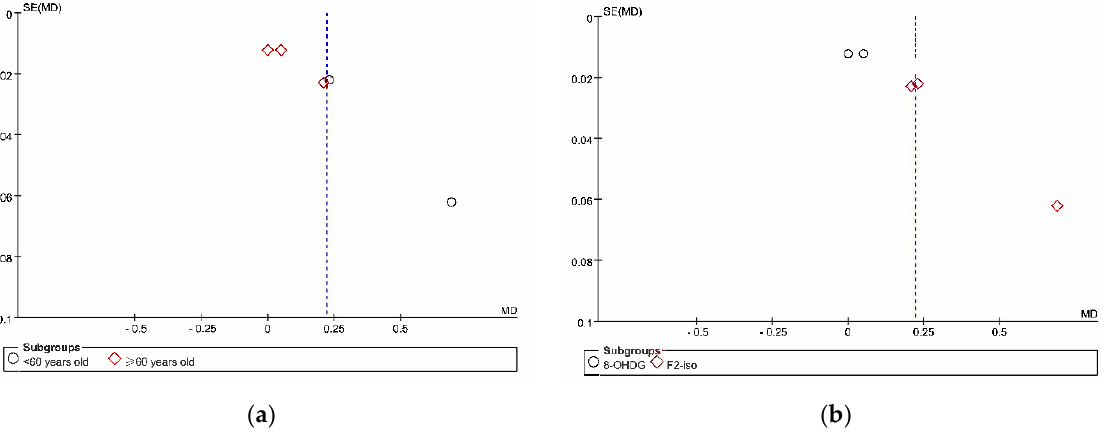
Figure 5. The funnel plots of the pair-wise meta-analysis. ( a ) Divided by the age of participants; ( b ) divided by outcome measures.